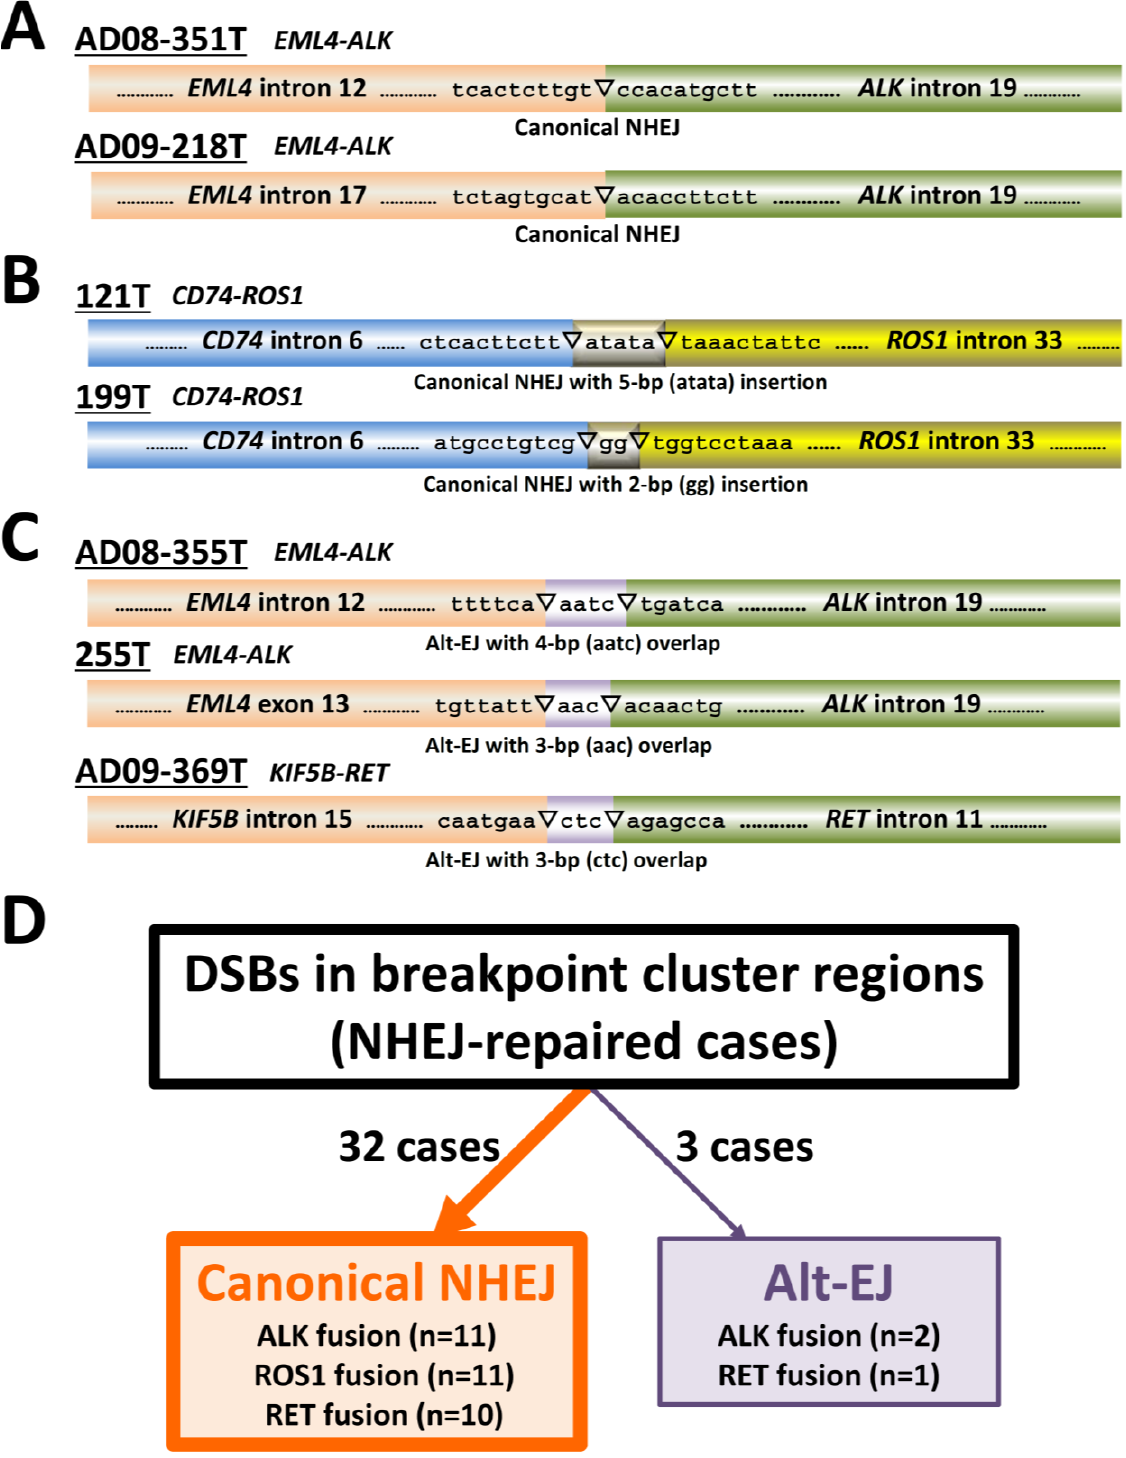
Figure 4. Deduction of non-homologous end joining (NHEJ) modes based on the structures of breakpoint junctions. (A and B) Representative cases in which reciprocal fusion was deduced to be caused by canonical NHEJ. Joining was performed without ( A ) and with ( B ) nucleotide insertions. ( C ) Representative cases in which reciprocal fusion was deduced to be caused by alt-EJ. Joining was deduced to involve microhomologies of three or four base pairs. C, NHEJ causing gene fusions in LADC. Canonical NHEJ is a major NHEJ mode used for DNA